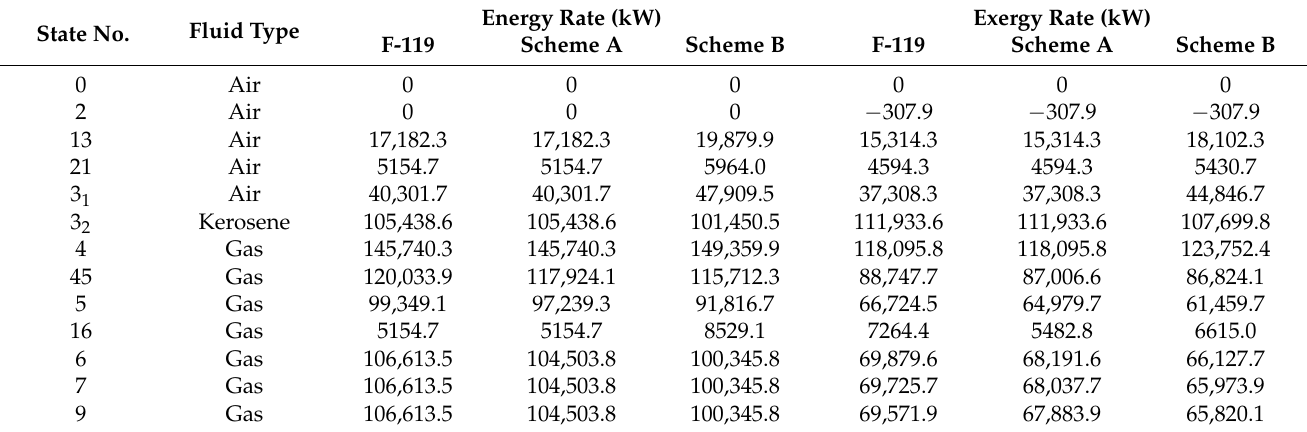
Table 6. Energetic and exergetic thermodynamic properties on design